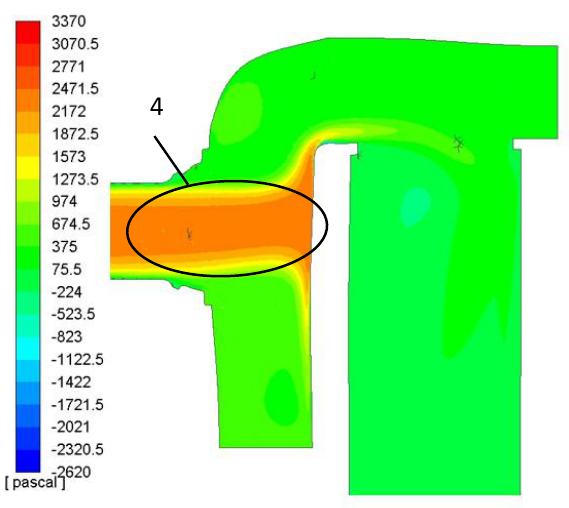
Fig. 12. Contours of Total Pressure p / Pa: modified